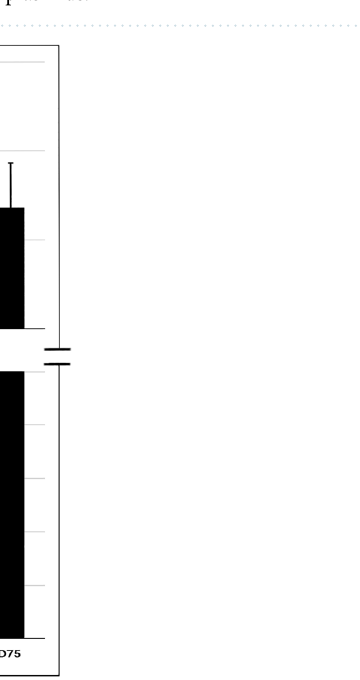
Figure 5. Comparison of TILD versus circular DNA donors for HDR induction. The pSGD plasmids carrying the CRISPR system and the DNA donor which had BamH1 restriction sequence at both 5 ′ and 3 ′ ends. The constructs were digested with BamHI enzyme to release the TILD fragments and co-transfected with the corresponding gRNA-encoding plasmid into MEF cells carrying the Venus transgene. The Venus knockout rate was compared between TILD and circular plasmids. The same process was used for the pSGD75 which induced both HDR and NHEJ knockout. This plasmid was considered as the positive control for transfection